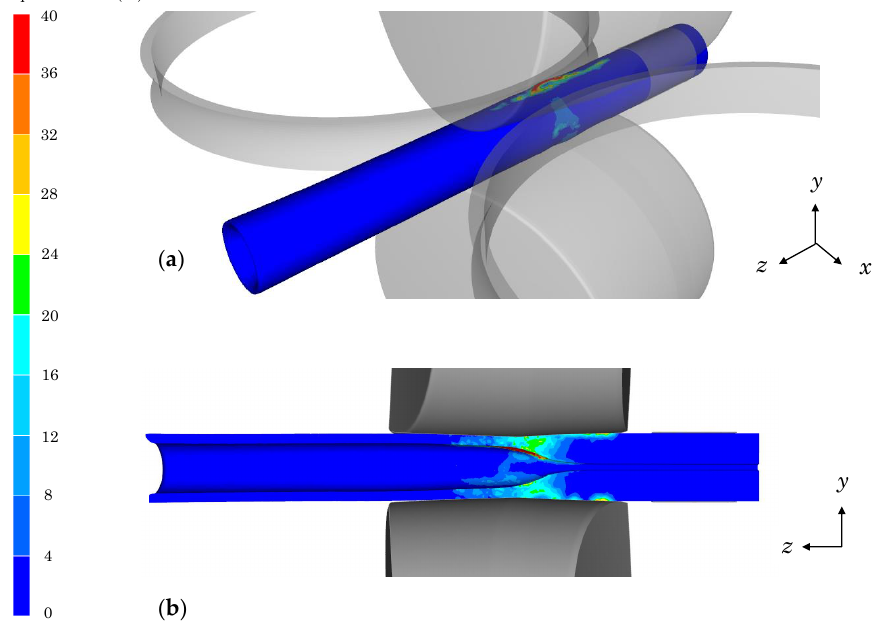
Figure 5. Strain rate distribution during the rotary tube piercing (RTP) process: ( a ) isometric projection, ( b ) z–y plane.